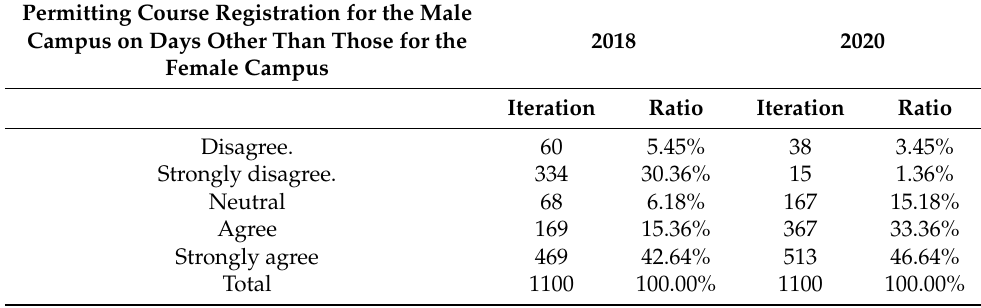
Table 9. Distribution of student numbers according to their feedback on allowing course